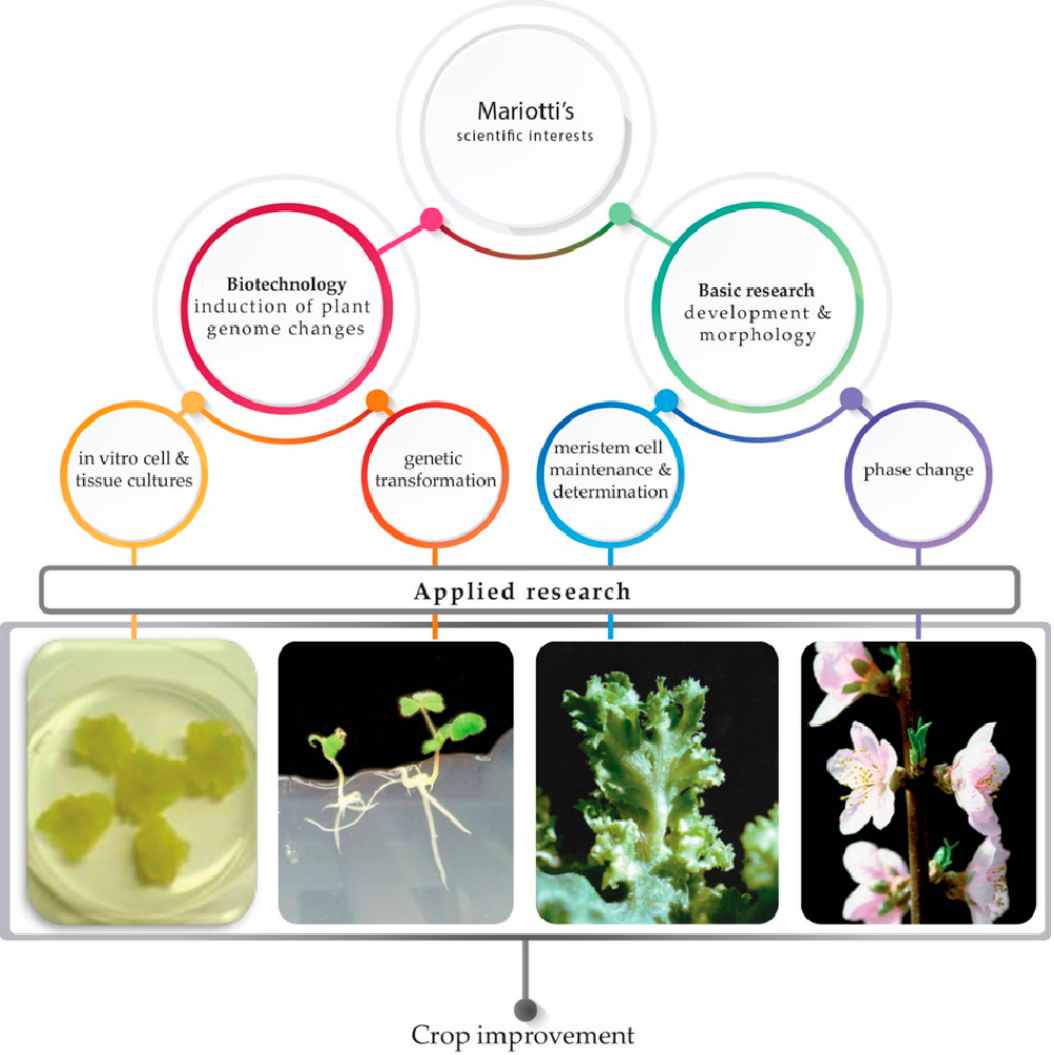
Figure 1. Outline of the main fields explored in this review following Mariotti’s scientific interests.